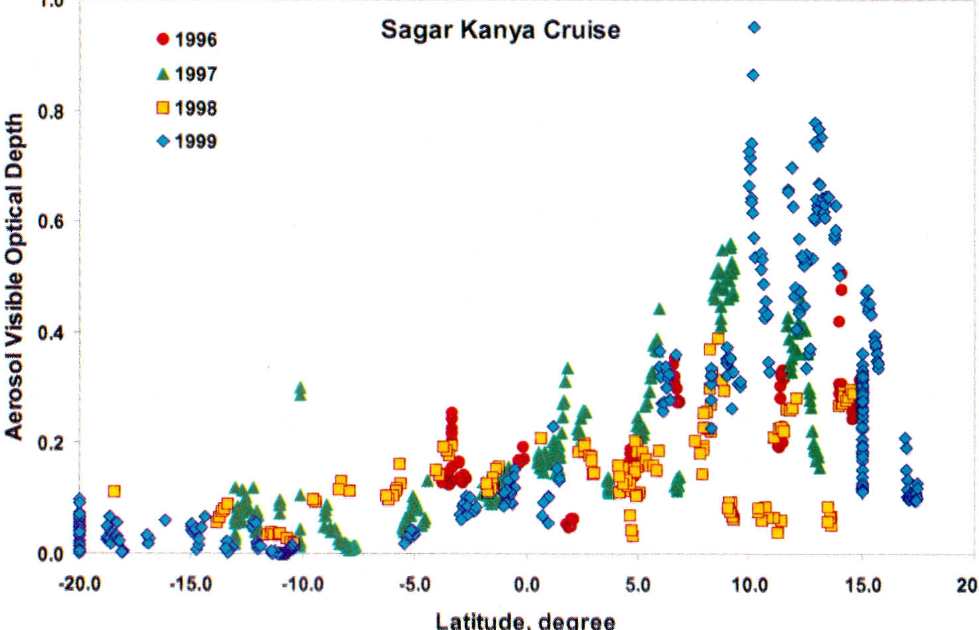
Fig. 21. Variation of Aerosol Optical Depth (AOD) as a function of latitude, based on measurements made during the four RV Sagar Kanya cruises during 1996–1999 (from Ramanathan et al., 2001, copyright 2001 by the American Geophysical Union, reproduced with